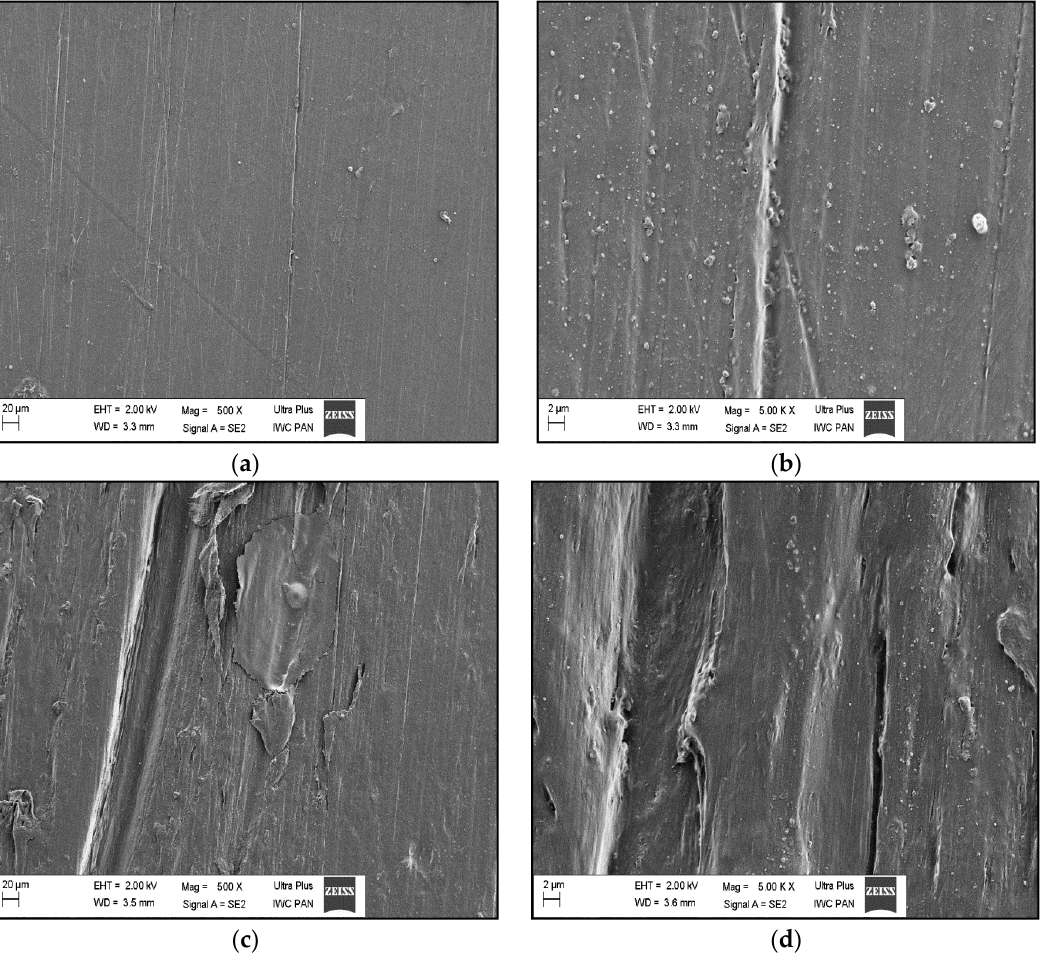
Figure 11. ( a , b ) SEM images of a “virgin” geogrid sample and ( c , d ) an aged “Radiowo” geogrid